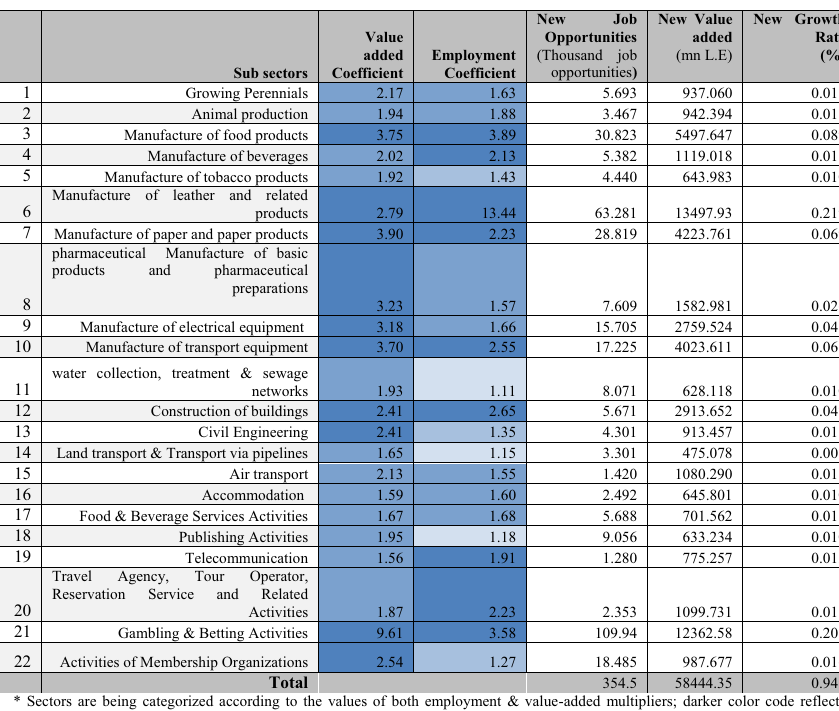
Figure 7. Effects of the FSP on both growth and employment